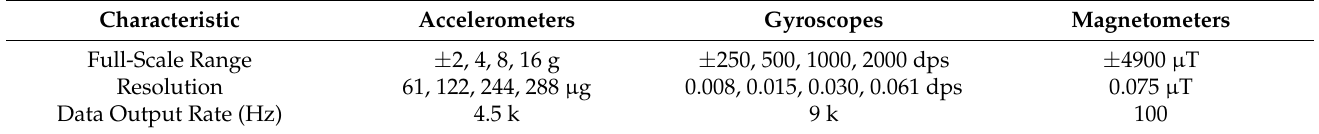
Table 1. TDK InvenSense ICM-20948 Technical Specifications